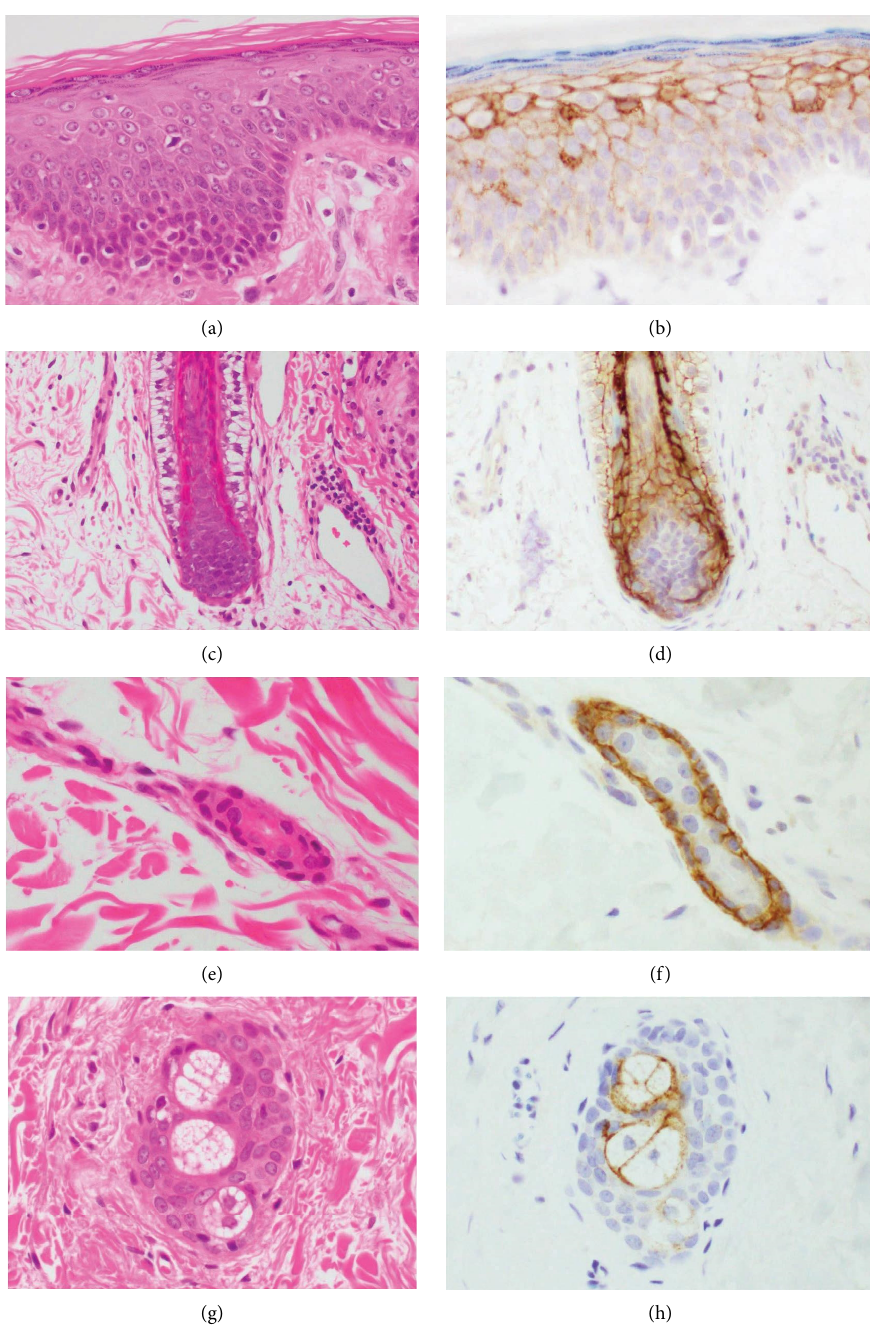
Figure 1: Representative immunohistochemical results for claudin 1 (b, d, f, and h) and corresponding HE-stained sections (a, c, e, and g) in normal skin. (a) Microphotograph of epidermis. (b) Reactivity is observed in the membrane of the basal to granular layer. Staining intensity is strongest in the stratum spinosum with occasional cytoplasmic reactivity. (c) Microphotograph of a hair follicle. (d) Hair follicle is positive and intensity is highest in the membrane and cytoplasm of the inner root sheath. (e) Microphotograph of a sweat gland. (f) Myoepithelial cells are positive for claudin 1. (g) Microphotograph of a sebaceous gland. (h) Membranous reactivity for claudin 1 is seen in sebaceous